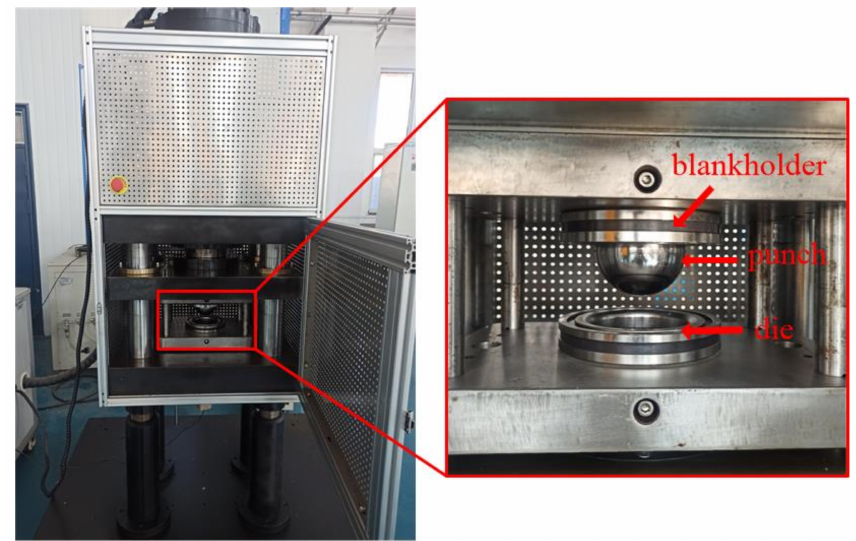
Figure 5. Sheet forming test machine.